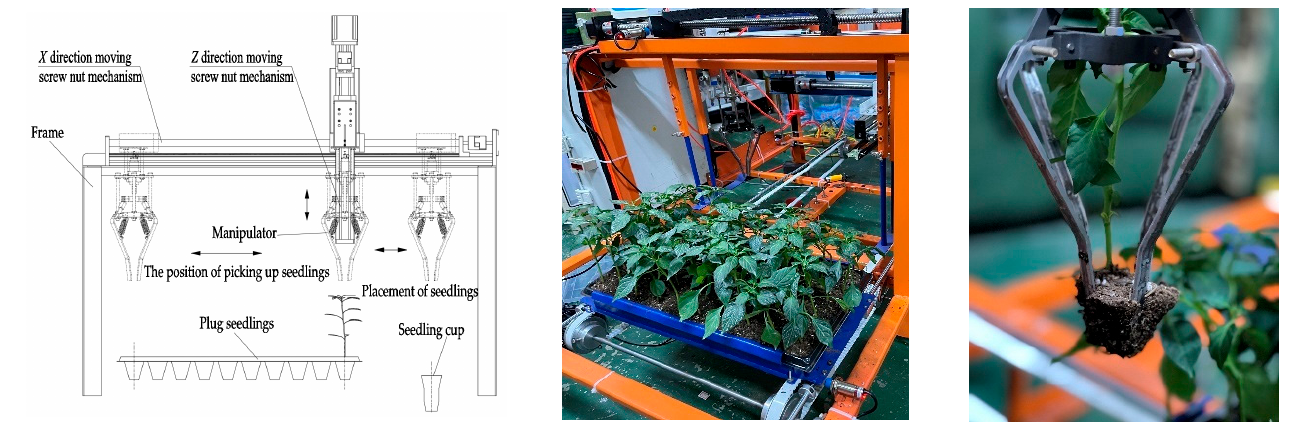
Figure 14. Picking up seedling test by manipulator.